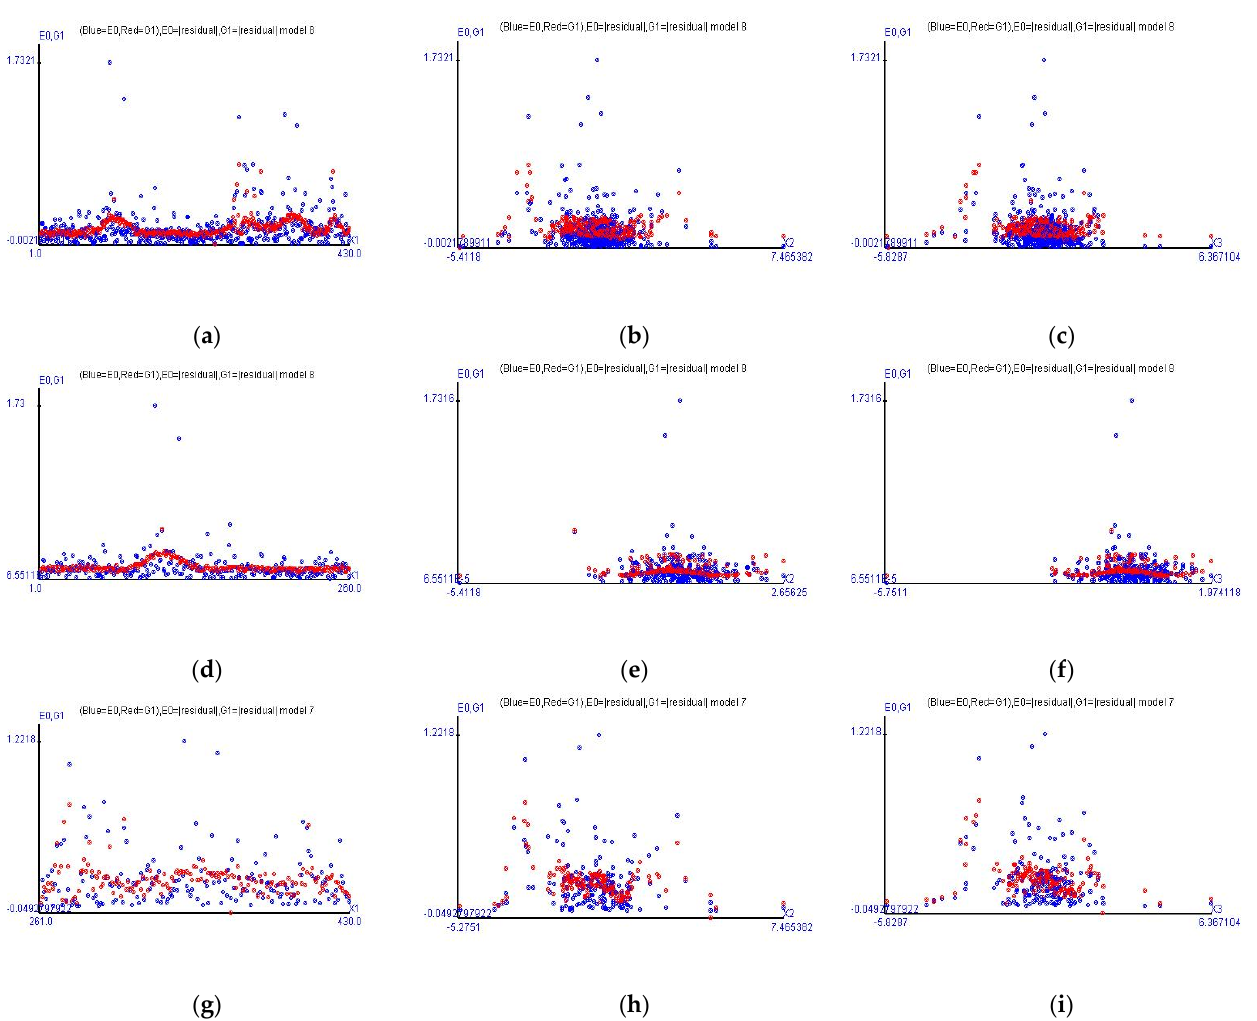
Figure 2. The fitted residuals result of heteroscedasticity. ( a – c ) is Case 1; ( d – f ) is Case 2; and ( g – i ) is Case 3. See Appendix B with the plots of only the fitted values of the heteroscedastic estimation.